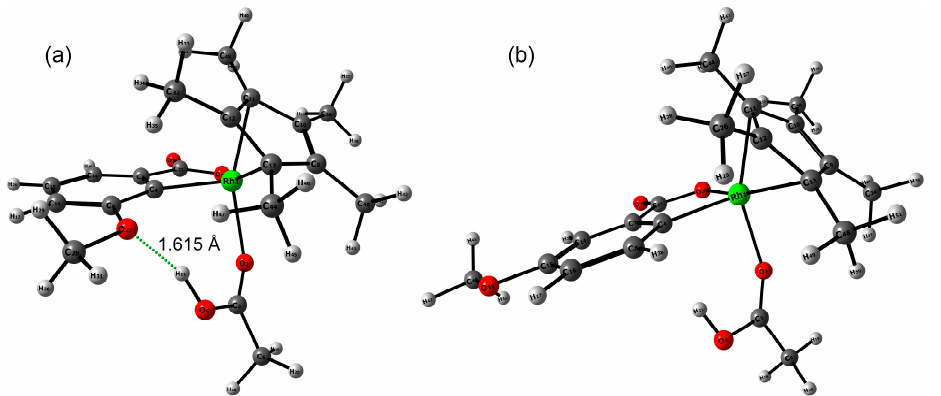
Figure 7. Intermediates Int1_Cp* ( a ) and Int’1_Cp* ( b ), optimized at the M06L(D3)/LANL2DZ level. The intramolecular distance O27 ⋯ H21 is equal to 1.615 Å.